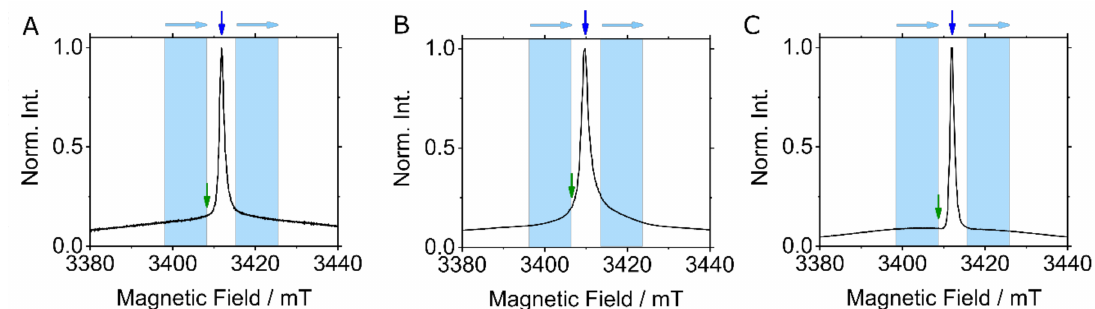
Figure 3. The normalized, echo-detected EPR spectra of ( A ) Ubi-DOTA-M-Gd, ( B ) Ubi-DO3A-Gd and ( C ) MdfA-C2-Gd. For DEER with a rectangular pump pulse, the signal was observed at the position indicated by a green arrow and pumped at the maximum of the central transition (blue arrow). For chirp DEER and rDEER, the signal was observed at the maximum of the central transition (blue arrow) and pumped on both sides by two 300 MHz wide chirp pulses (blue areas). The direction of the linear chirp is indicated by light blue arrows above the respective pump